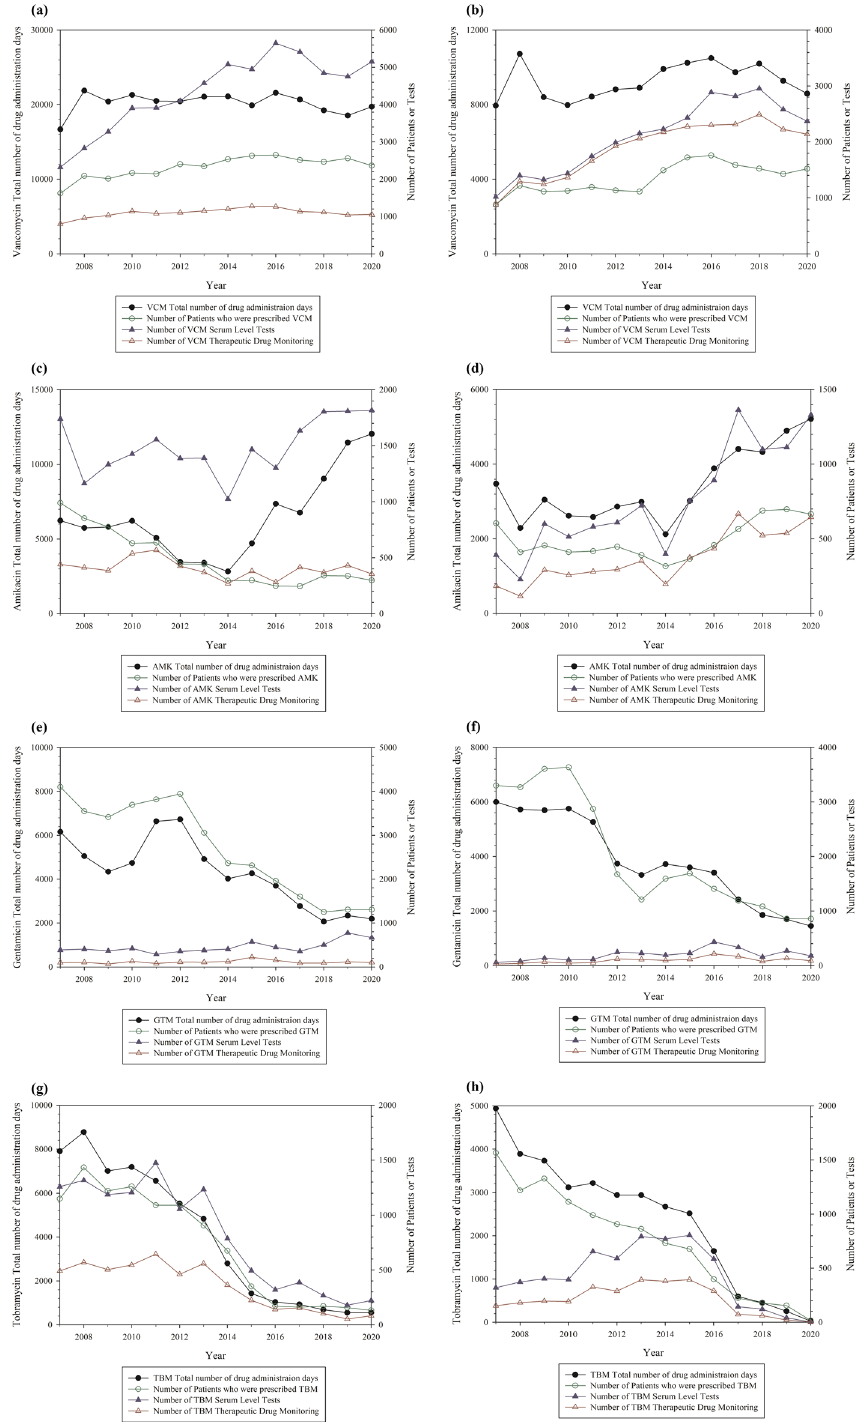
Figure 3. Analysis of the total number of drug administration days and the cases of serum level tests and therapeutic drug monitoring by year in Seoul National University Hospital or Seoul National University Bundang Hospital (Antibiotics: vancomycin, amikacin, gentamicin, and tobramycin). ( a ), ( c ), ( e ), ( g ) for Seoul National University Hospital and ( b ), ( d ), ( f ), ( h ) for Seoul National University Bundang Hospital. The left y-axis represents the total number of drug administration days and the right y-axis represents the number of patients who were prescribed drugs and the number of serum level tests or therapeutic drug monitoring. Abbreviation: VCM, vancomycin; AMK, amikacin; GTM, gentamicin; TBM,